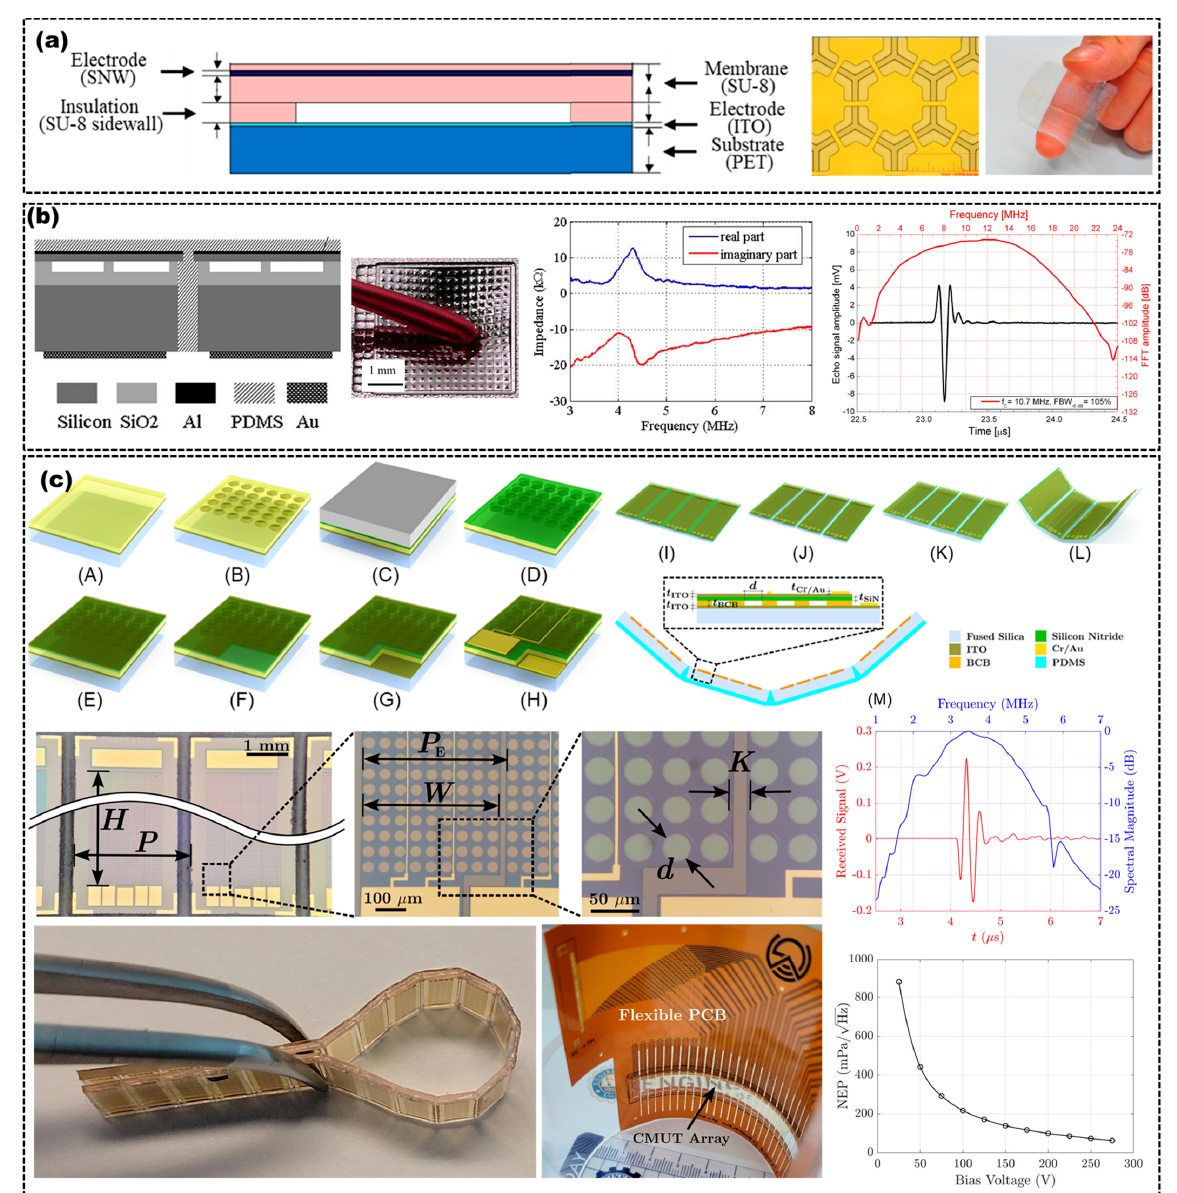
Figure 6. ( a ) Cross ‐ sectional view of a CMUT unit ( left ), optical images ( right ) of a flexible CMUT array. Adapted from [57]. ( b ) Cross ‐ section schematic of two flexible CMUT array elements ( first ), optical picture ( second ) and electrical impedance spectrum ( third ) of a 2 − D CMUT array and fre ‐ quency spectrum of a single element of a flexible CMUT array ( fourth ). Adapted from [58,59]. ( c ) Fabrication process and 2D cross ‐ sectional view ( top ), optical images ( middle and bottom left ), fre ‐ quency spectrum ( middle right ) and NEP ( bottom right ) of a transparent flexible CMUT array. Adapted from [15]. Pang et al. presented a transparent flexible CMUT array, which comprises a tin oxide ‐ PET (ITO ‐ PET) substrate, an SU − 8 sidewall and vibrating membranes, and a sliver nan ‐ owire electrode, as shown in Figure 6a [57]. Chen et al. reported flexible CMUT arrays, which exhibited a 4.5 MHz center frequency with a –3 dB fractional bandwidth of 82% [60]. Zhuang et al. proposed a technique for constructing flexible CMUT arrays by etching